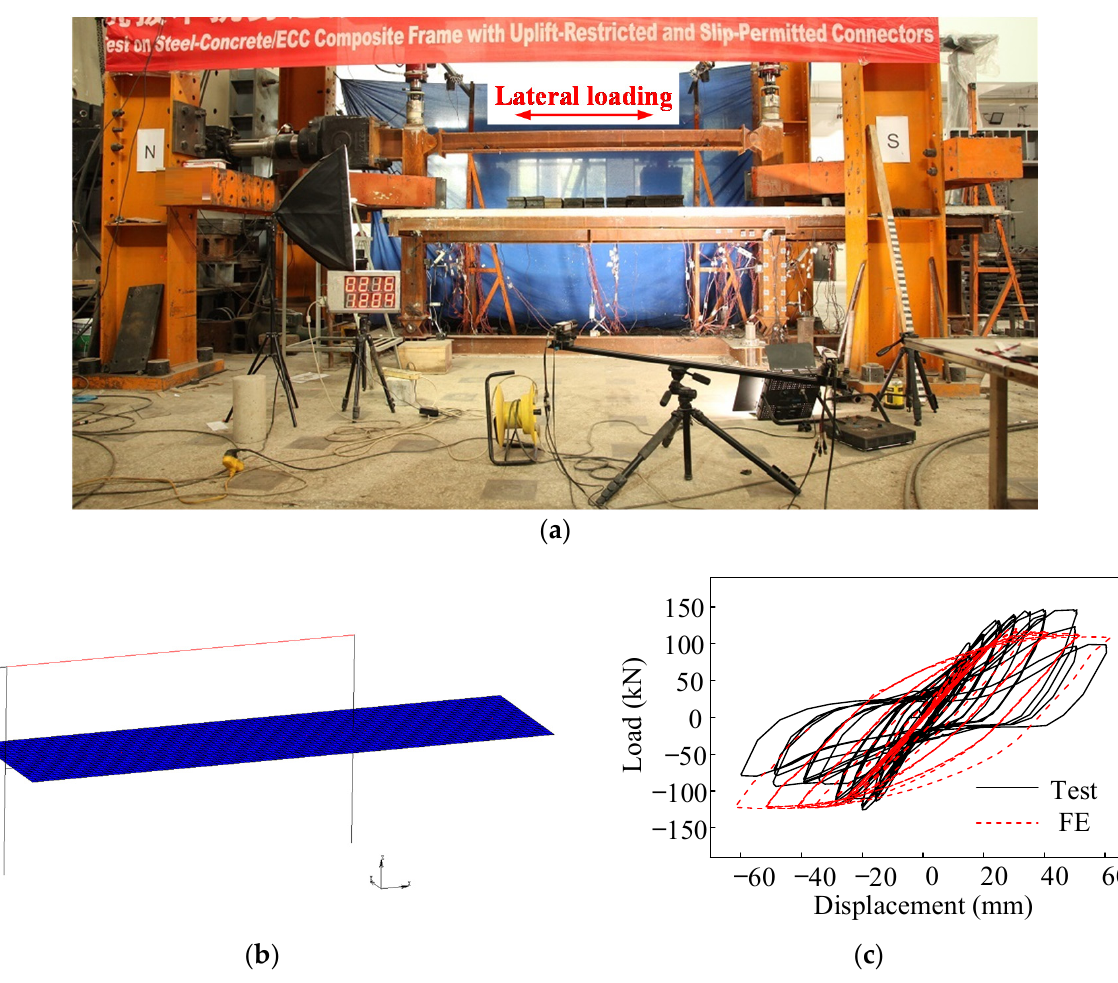
Figure 3. The validation of the FE model with test results: ( a ) test photo of the composite frame with URSP connectors [37]; ( b ) FE model of the test specimen; ( c ) comparison of test and FE model load–displacement curves.